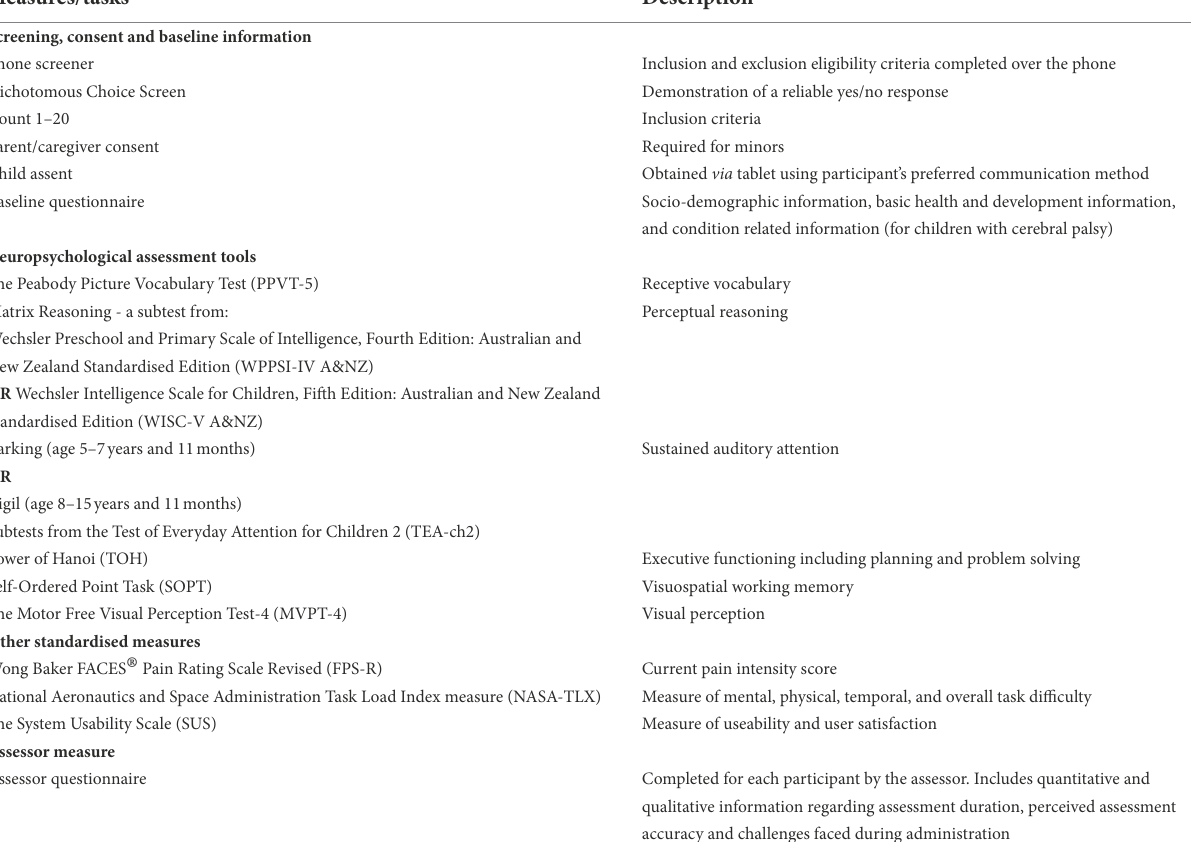
TABLE 1 Included measures/tasks per